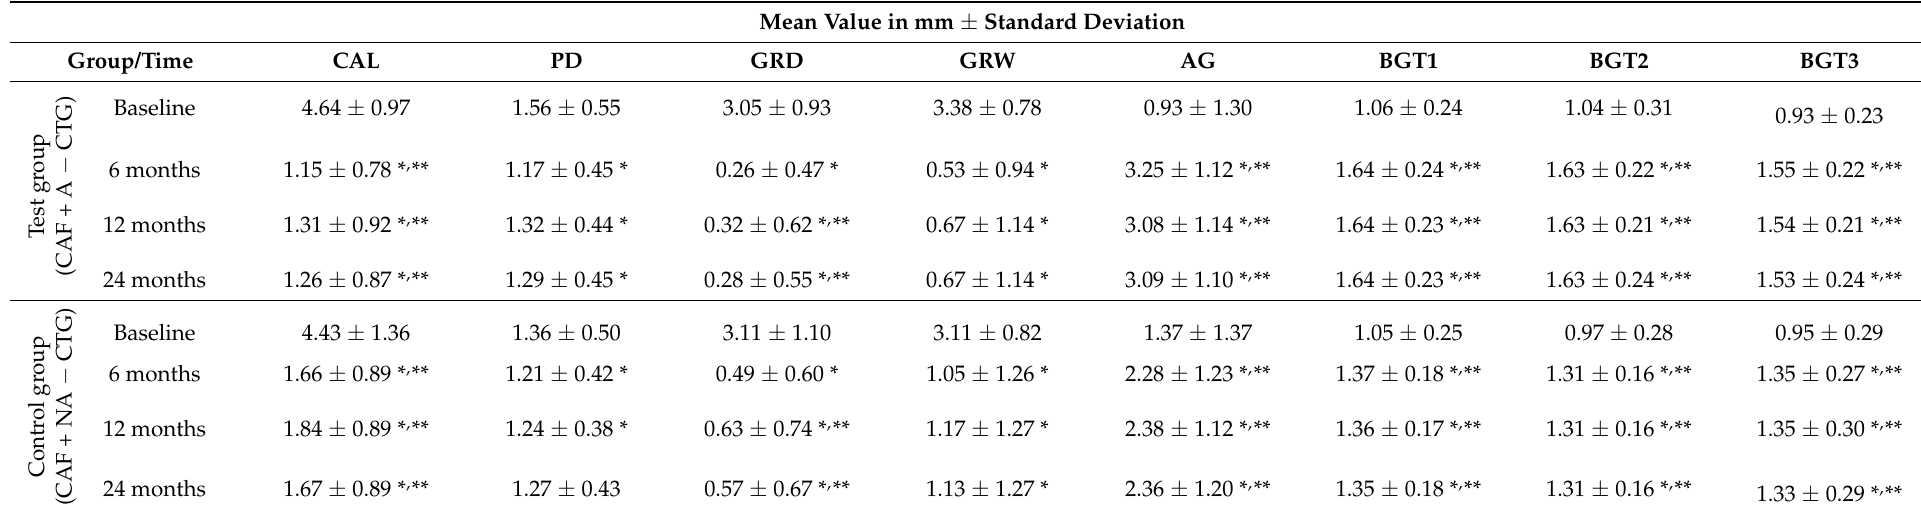
Table 2. Clinical parameters at baseline, 6, 12 and 24 months after